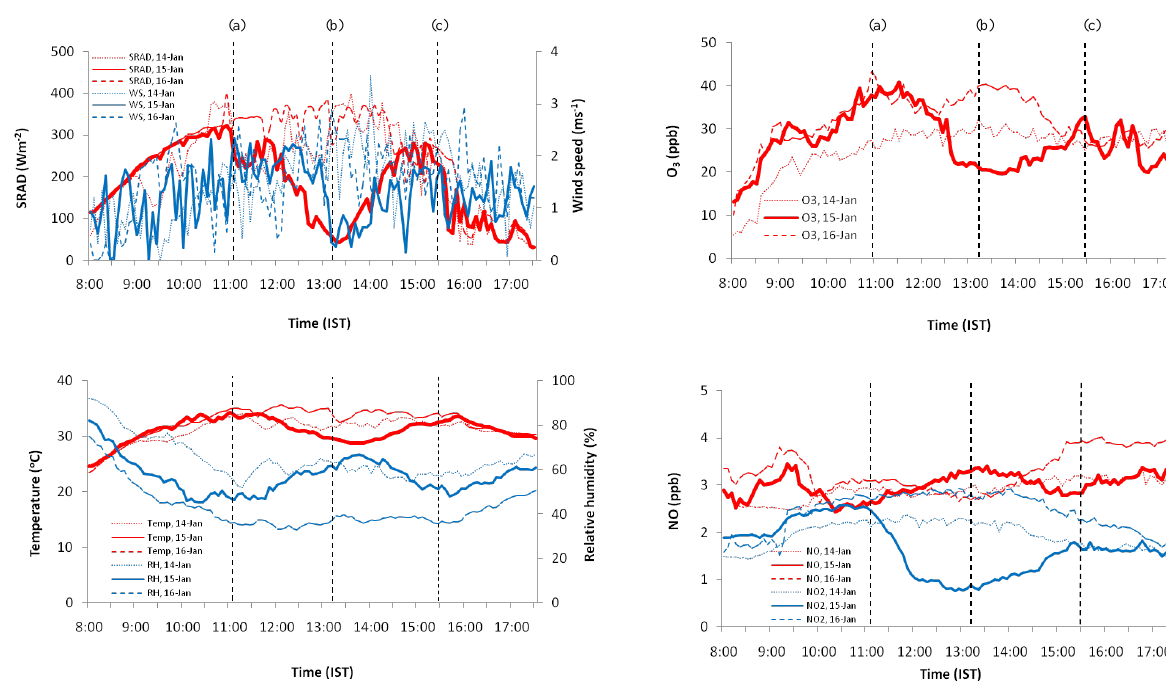
Figure 2: Surface O 3 , NO and NO 2 , measured before, during and after the total solar eclipse 529 Fig. 2. Surface O 3 , NO and NO 2 , measured before, during and after occurred on 15 January, 2010 at Thiruvananthapuram, India, (a) beginning of the 530 solar eclipse, (b) solar eclipse maximum, (c) end of the solar eclipse along with a day 531 the total solar eclipse occurred on 15 January 2010 at Thiruvanan- before and a day after of the solar eclipse. 532 thapuram, India, (a) beginning of the solar eclipse, (b) solar eclipse 533 534 maximum, (c) end of the solar eclipse along with a day before and a day after of the solar